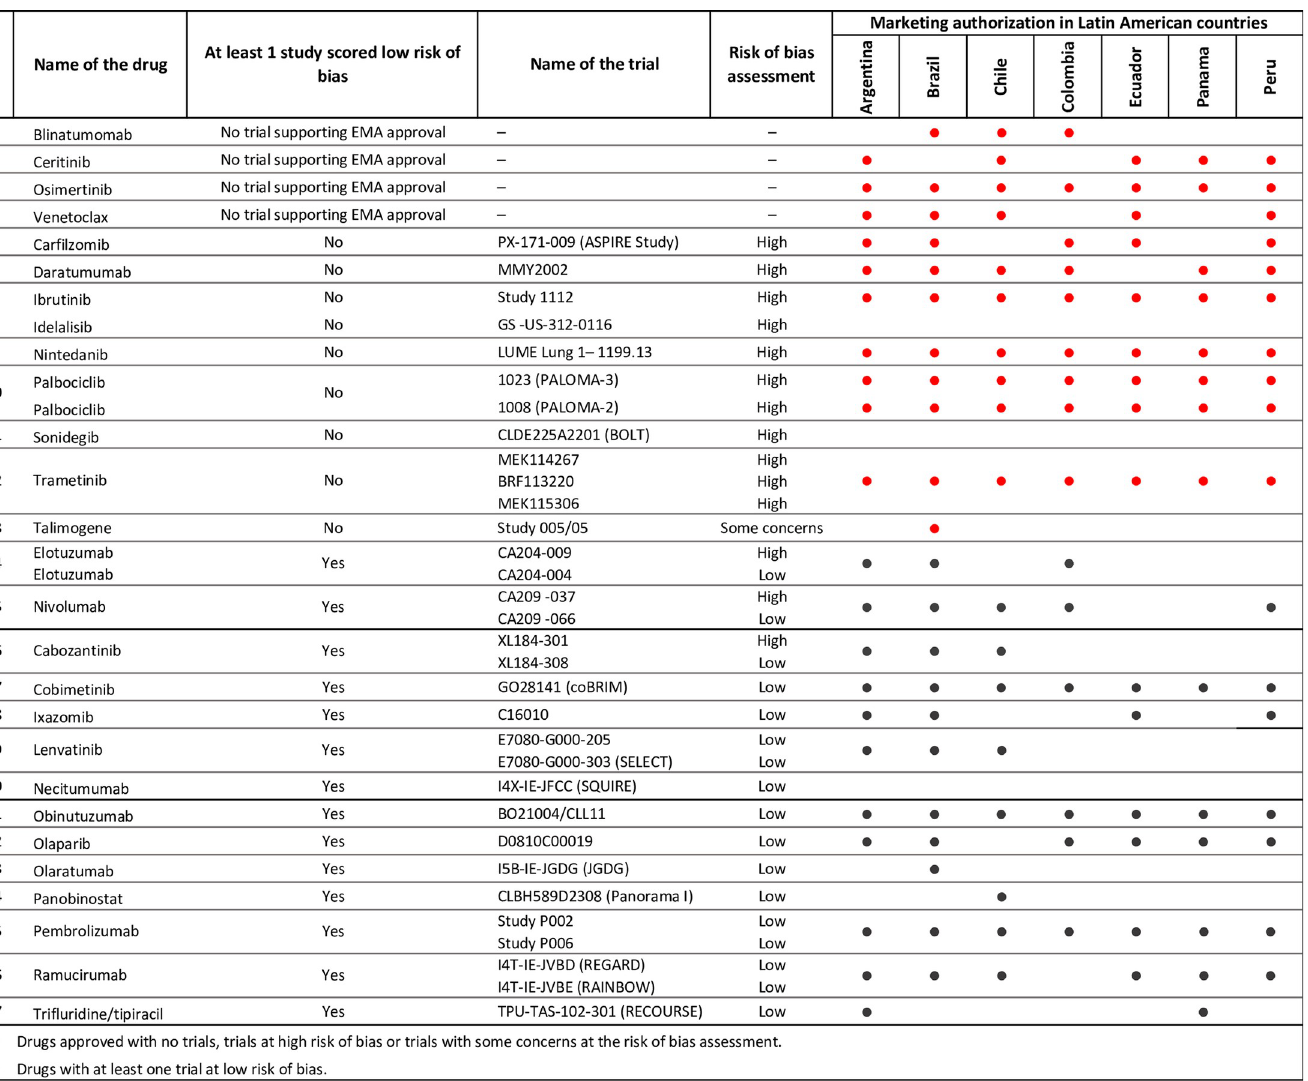
Fig 4. Clinical trials’ risk of bias assessment of new cancer drugs approved by 7 Latin American countries (2014–2016).